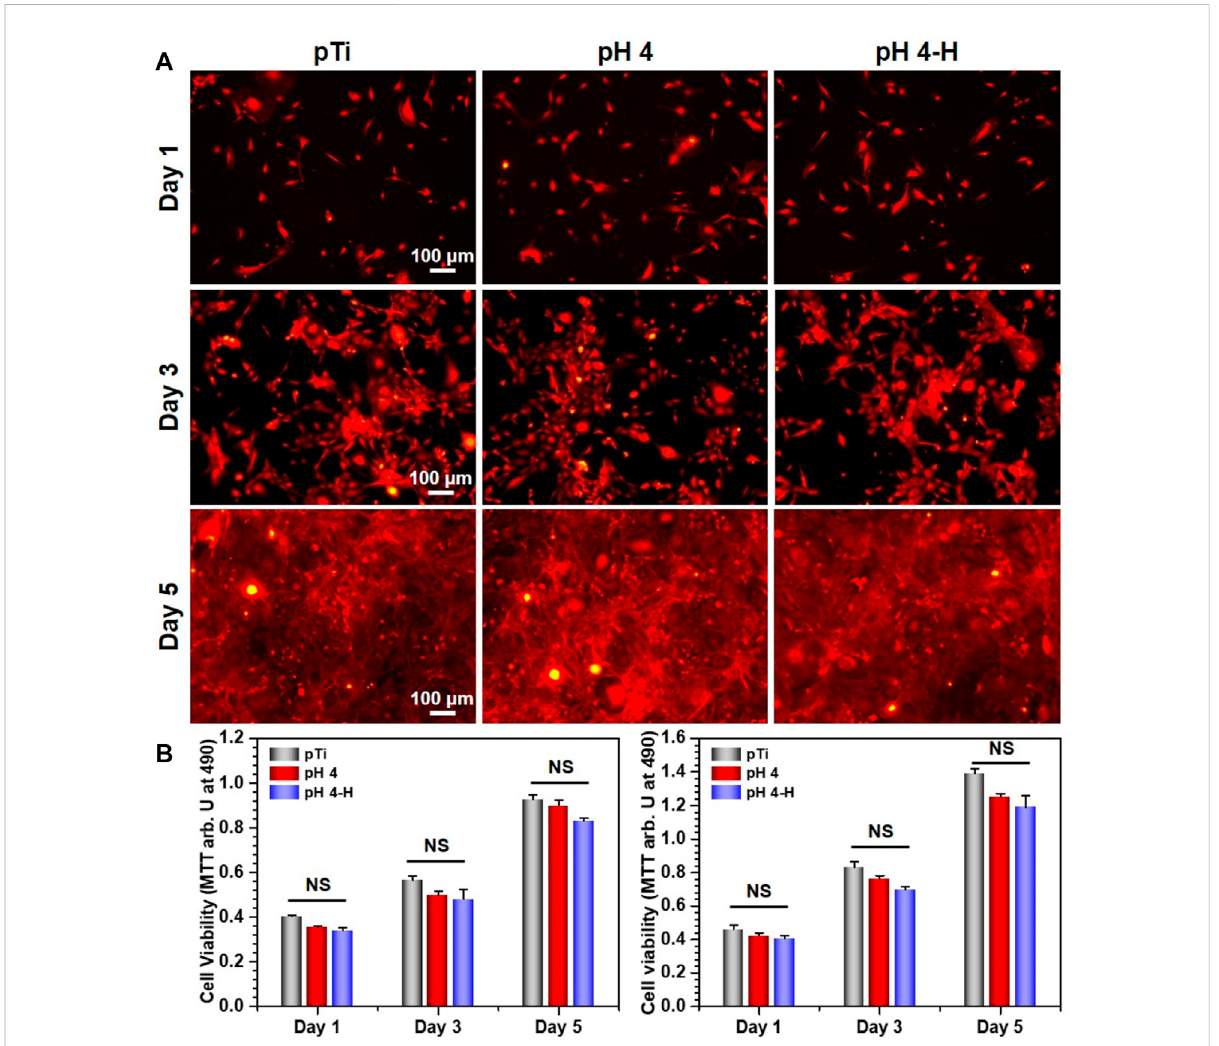
FIGURE 5 Biocompatibility evaluation of samples in group pH 4 and pH 4-H: (A) YF555-phalloidin (for F-actin) and DAPI (for nuclei) staining of MC3T3-E1 on various samples; (B) Left: MTT tests for MC3T3-E1of various samples. Right: MTT tests for MC3T3-E1 of leach liquor of various samples. NS: no signi fi